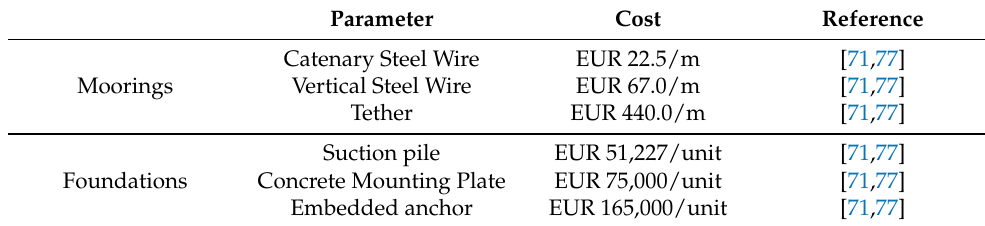
Table 1. Summary of unitary mooring and foundation